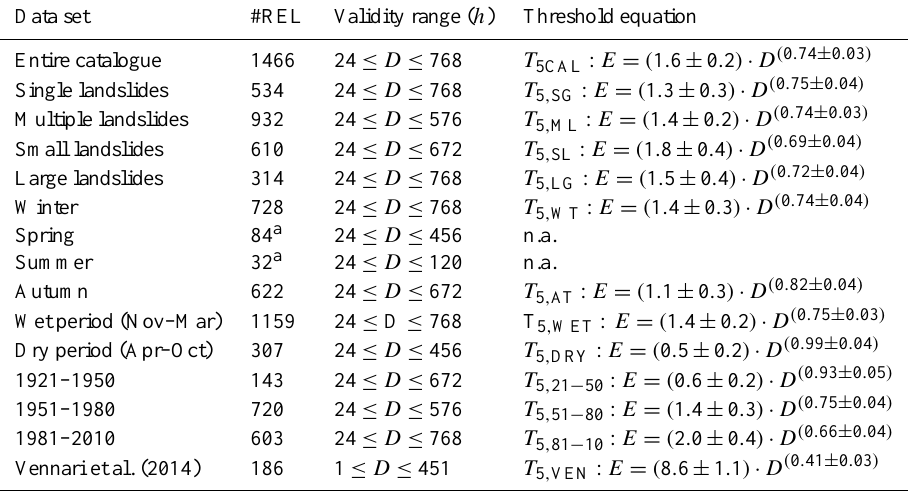
Table 3. Cumulated event rainfall-rainfall duration (ED) thresholds, at 5% exceedance probability, for rainfall-induced landslides in Calabria, for the entire catalogue and for different subsets. #REL is the number of rainfall events used to define the